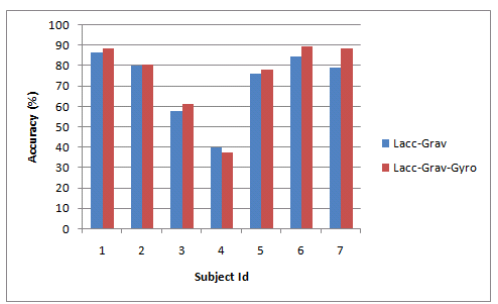
Figure 8: Accuracies for person-independent classification